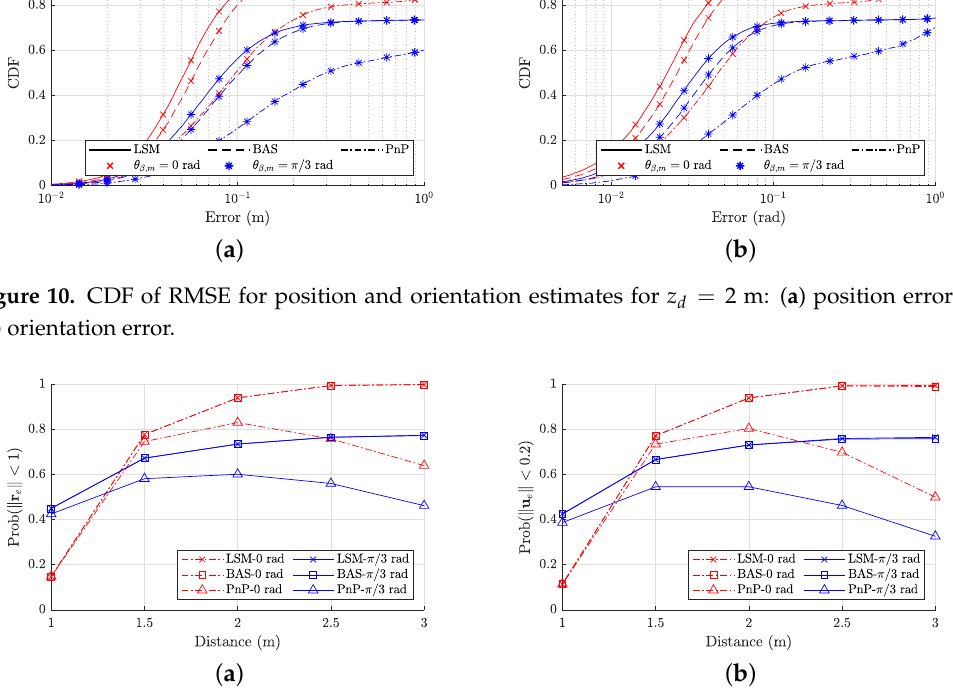
Figure 11. Probability versus the distance z d for: ( a ) position error (cid:107) r e (cid:107) < 1 m; ( b ) orientation error (cid:107) u e (cid:107) < 0.2